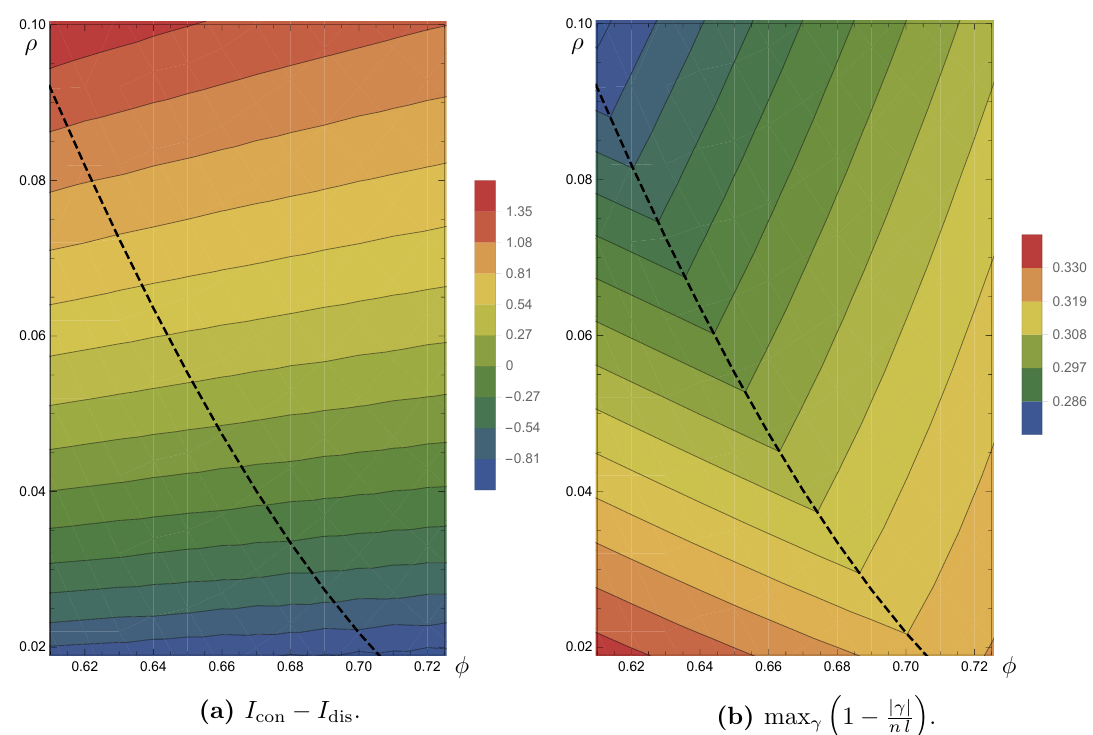
Figure 3 . Comparison of the actions for the connected and disconnected phases in the symmet- ric con(cid:12)guration. The parameters ( (cid:30); (cid:26) ) are the angular position and size of C 1 on the Riemann sphere. The dashed line corresponds to the particular con(cid:12)guration with an additional (cid:25)= 2 rota- tional symmetry about the axis orthogonal to the plane of the page in (cid:12)gure 2a and (cid:12)gure 2c (see also (cid:12)gure 4).